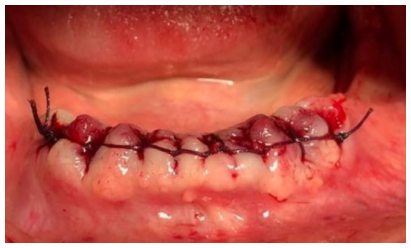
Figure 2. Immediate post-surgical condition, Group A.